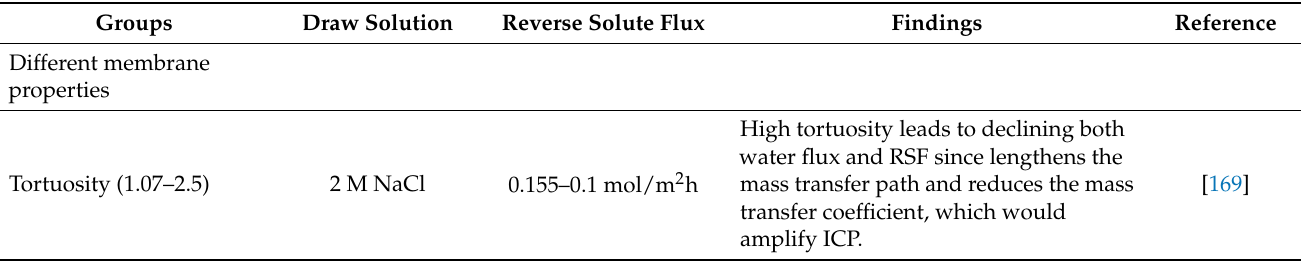
Table 5. Recent studies on factors affecting reverse solute flux (RSF) for the FO process. Groups Draw Solution Reverse Solute Flux Findings Reference